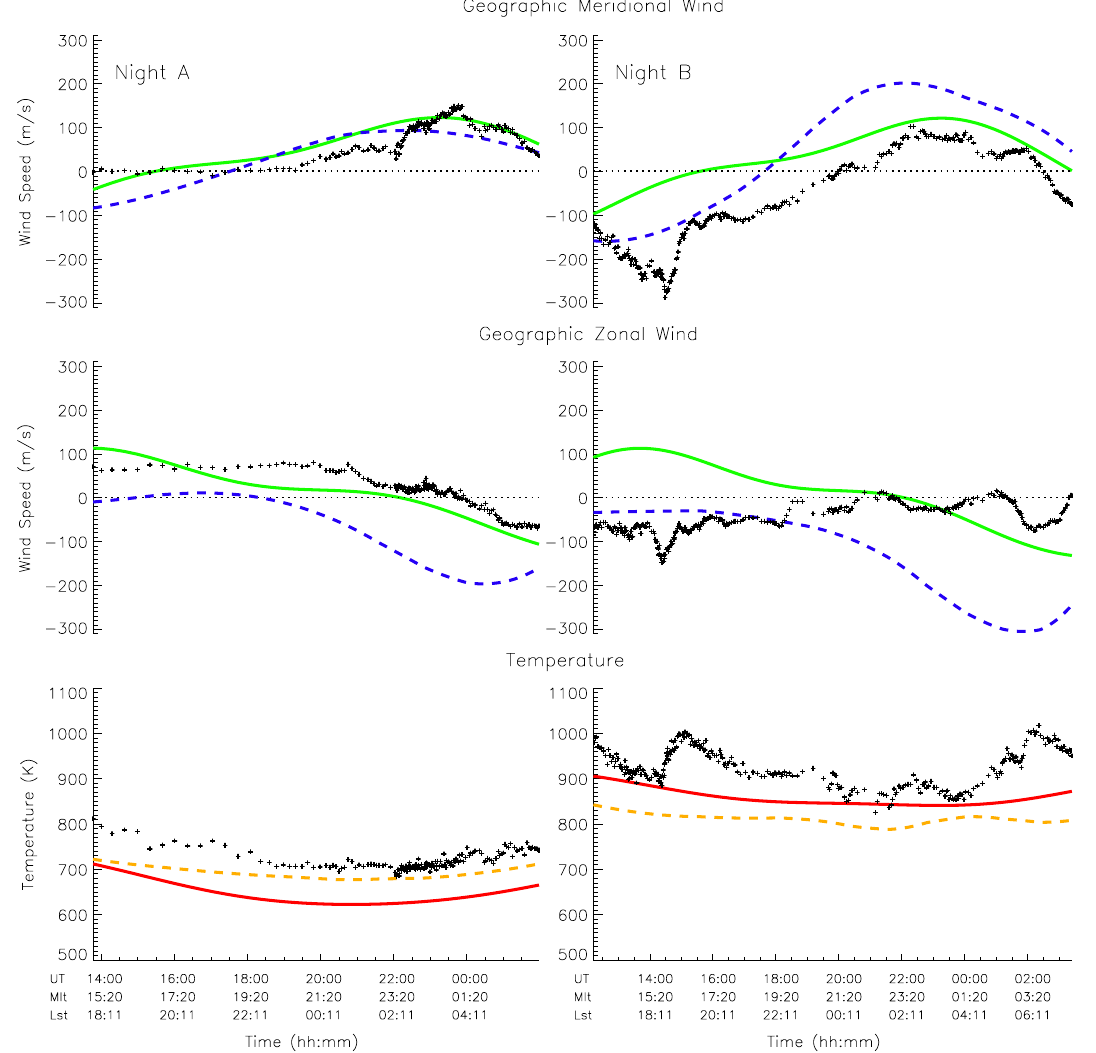
Fig. 4. Winds and temperatures observed on nights A and B. Typical uncertainty in observed wind speed and temperature is around 10ms − 1 and 45K, respectively. HWM93 (solid green curve) and CTIP (dashed blue curve) predicted winds are shown, along with temperatures output by CTIP (dashed orange curve) and NRLMSISE-00 (solid red curve). Inputs to models were constant over the observing